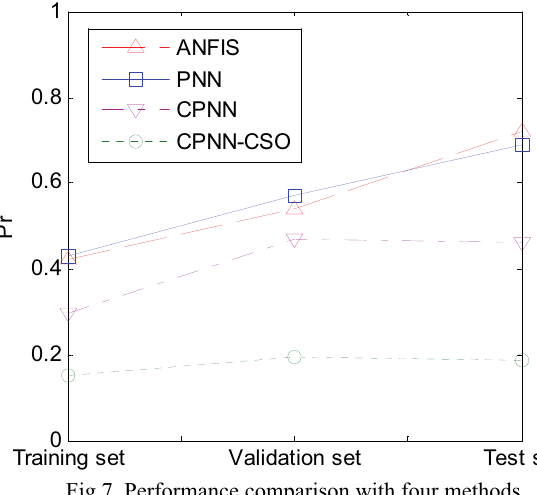
Fig.7. Performance comparison with four